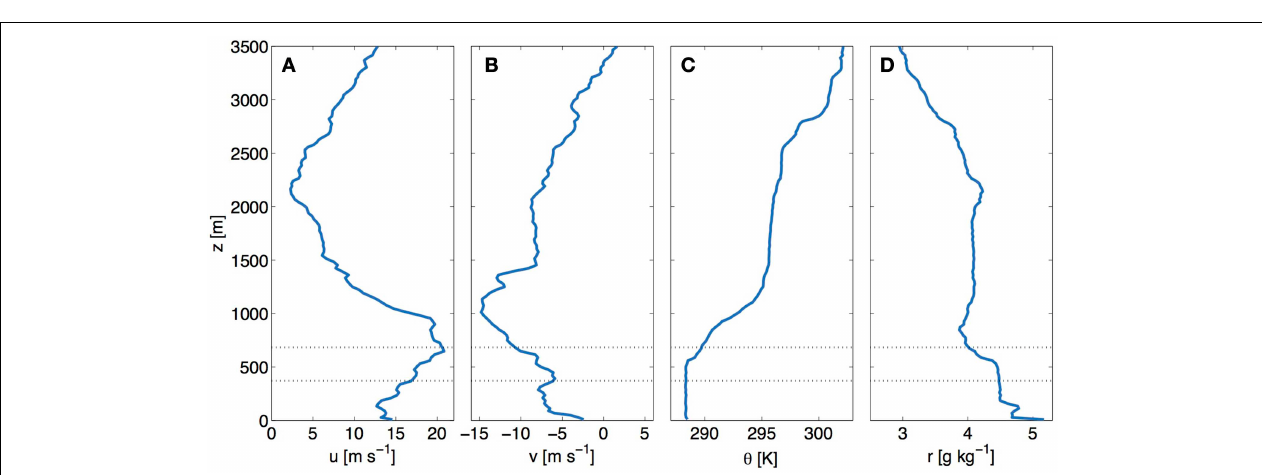
FIGURE 3 | Spatial structure of the weighted energy spectra k * S(k) along the entire upper (A–C) and lower (D–F) ABL flight leg for u (A,D), v (B,E) and w (C, F) wind components. The two white horizontal dashed lines indicate the analyzed segment. A noticeable increase in energy at the horizontal scale of approximately 1 km is